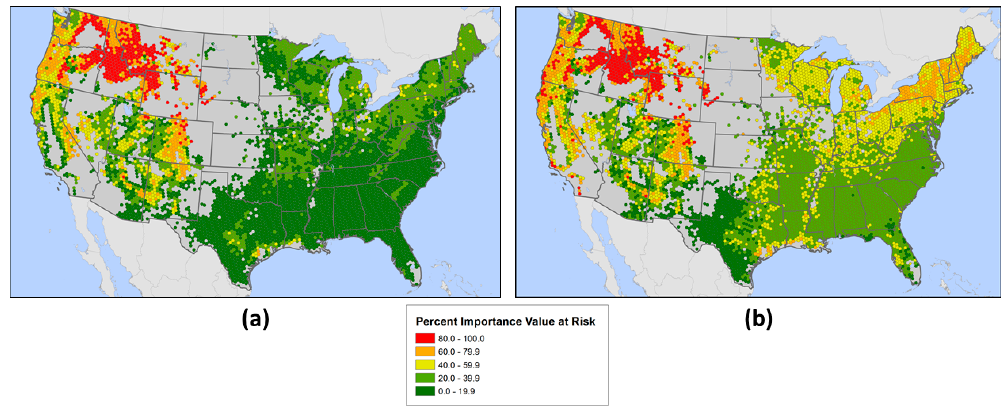
Figure 1. Mean percent host tree Importance Value at Risk (IVAR) for plots within 834 km 2 hexagons, encompassing both native and exotic insect and disease agents. ( a ) IVAR given the current county-level distribution of 39 highly damaging exotic insects and diseases. ( b ) IVAR given the possible future distribution extent of these exotics.